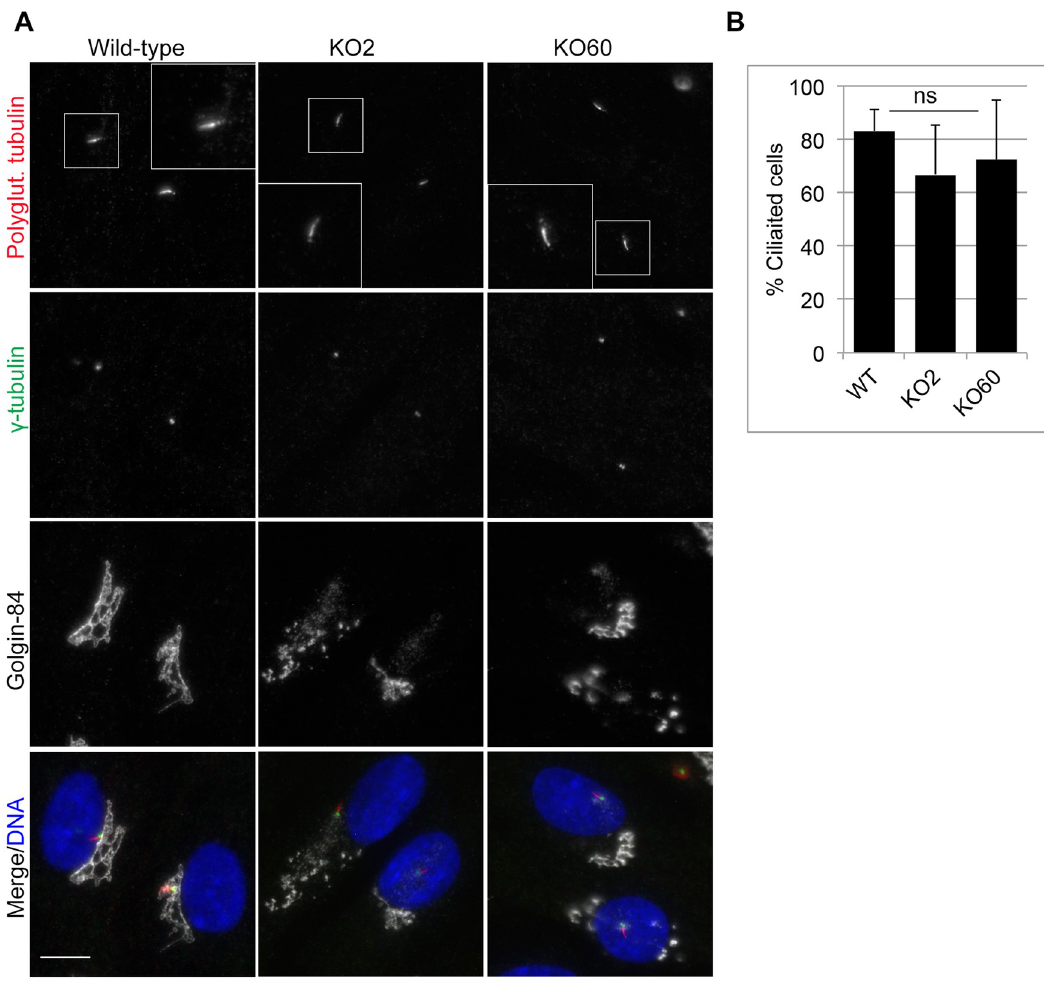
Fig 7. GM130 and Golgi-centrosome proximity are not necessary for ciliogenesis. A . Cilia formation was induced by serum withdrawal for 48 hours. Cells were fixed and stained with antibodies to polyglutamylated tubulin, γ -tubulin and Golgin-84 to visualize the ciliary axoneme, the basal body and the Golgi, respectively. Merged images with DNA stained with DAPI are also shown. Scale bar: 10 μ m. B . The percentage of cells with increased Golgi-centrosome distance that were ciliated was quantified. The data is from three independent experiments with at least 50 cells per condition analyzed. ns = not statistically